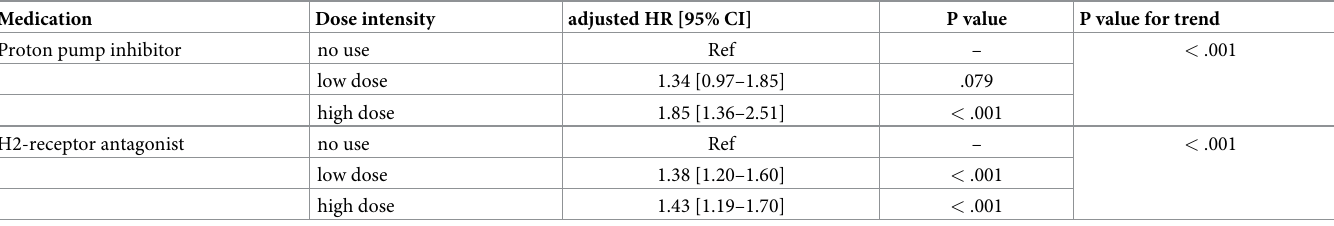
Data are derived by multivariate time-dependent Cox proportional hazard regression model adjusted for variables listed in Table 3. Abbreviations: HR, hazard ratio; CI, confidence